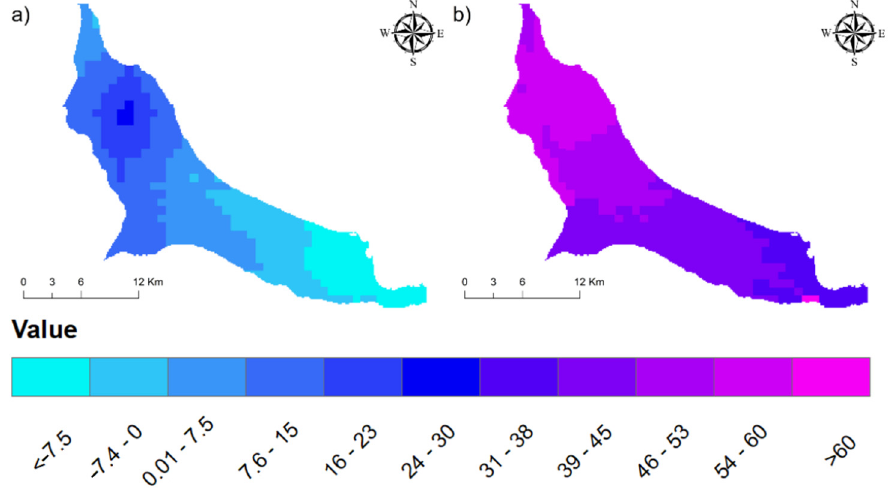
Figure 5. Spatial differences between the projected R factor ( a ) 2021–2050 and ( b ) 2071–2100 and the baseline period (1971–2000).